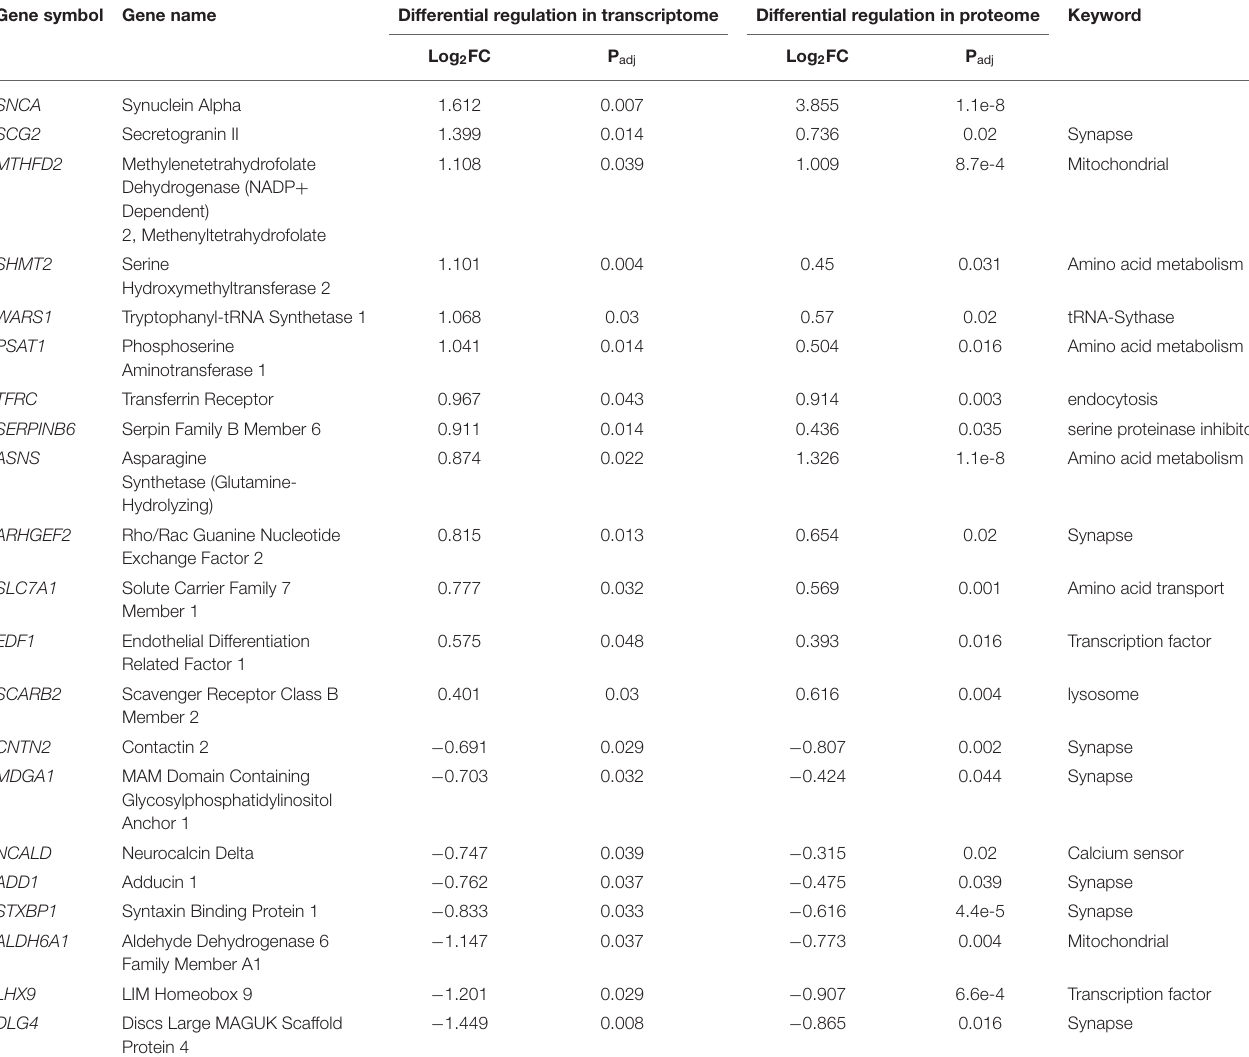
TABLE 3 | Regulation of the 21 transcripts/proteins that were differentially regulated between alpha-synuclein-overexpressing and GFP-expressing cells in the transcriptomic and proteomic